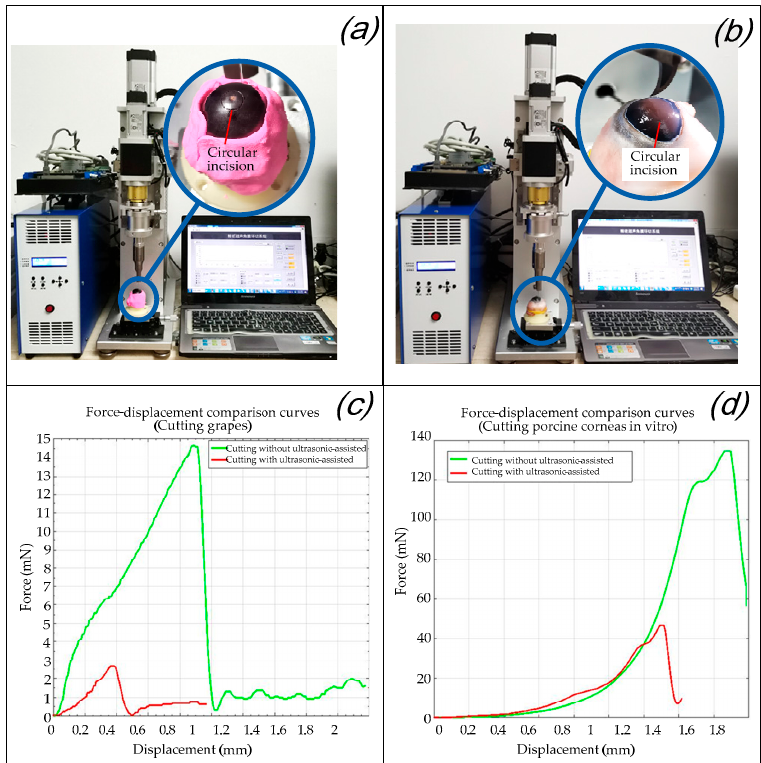
Figure 16. Validity verification experiment of the eccentric adjusting mechanism. ( a ) Trephination experiments on grapes. ( b ) Trephination experiments on porcine corneas. ( c ) Force–displacement comparison curves in the experiments of cutting grapes. ( d ) Force–displacement comparison curves in the experiments of cutting porcine corneas in vitro.